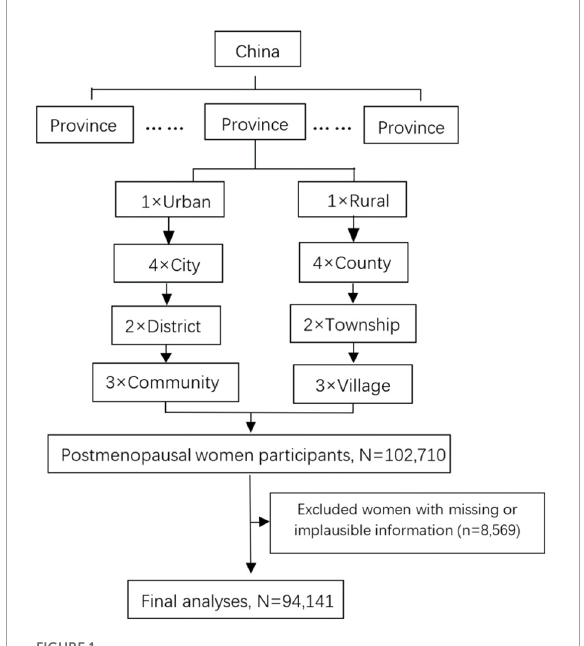
FIGURE1 Chart of the subject inclusion and exclusion. PPS, probability proportional to size; SRS, simple random sampling.